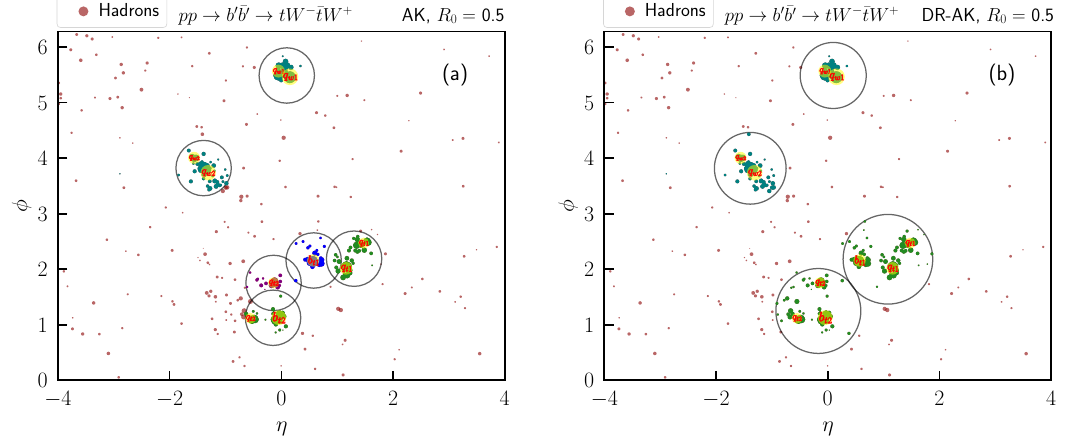
Figure 10 . The distribution of final state hadrons and jets in η - φ plane for an example event. The colours and sizes of the dots and circles follow the same convention as figure 1. The teal coloured dots represent the constituents of hard fat ‘W’ jets. The green and blue (wherever applicable) dots represent the constituents of the fat ‘top’ jet. The yellow dots containing texts represent the position of the hard quarks after the decay of top or W which are mentioned as the subscripts of q or b . The plots are shown for (a) AK and (b) DR-AK